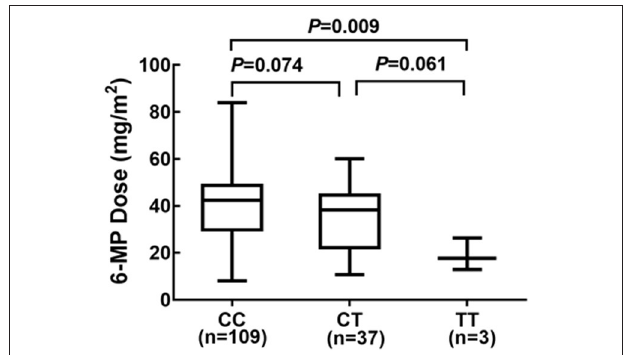
FIGURE 3 | Genotype of NUDT15 c.415C > T and 6-MP dose at maintenance period 109 patients with CC, and 6-MP dose 39.80 ± 1.32 mg/m 2 ; 37 patients with CT and 6-MP dose 35.20 ± 2.29 mg/m 2 ; 3 patients with TT and 6-MP dose 18.95 ± 3.95 mg/m 2 .